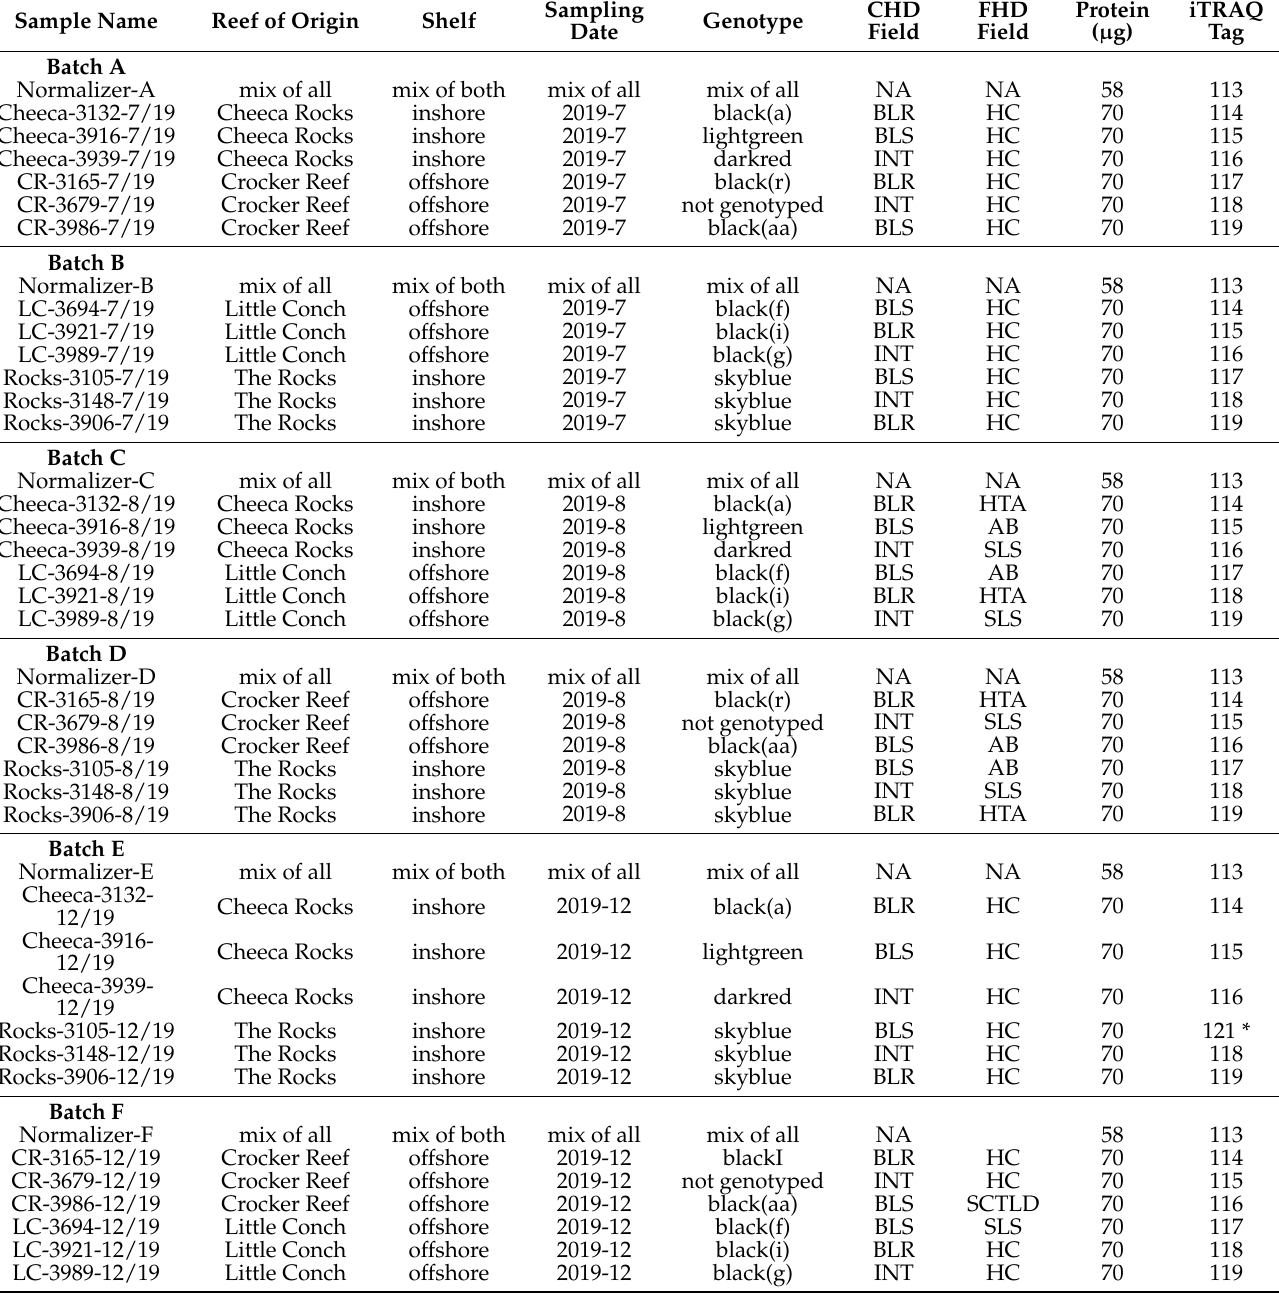
Table 2. Details of the 36 field samples. Colony health designations (CHD) were bleaching-resistant (BLR; n = 12), bleaching-susceptible (BLS; n = 12), or intermediate (INT; n = 12). For fragment health designation (FHD) abbreviations, see Table 1; HC, HTA, SLS, and AB sample sizes were 22, 4, 5, and 4, respectively. One colony instead succumbed to stony coral tissue loss disease (SCTLD). NA = not